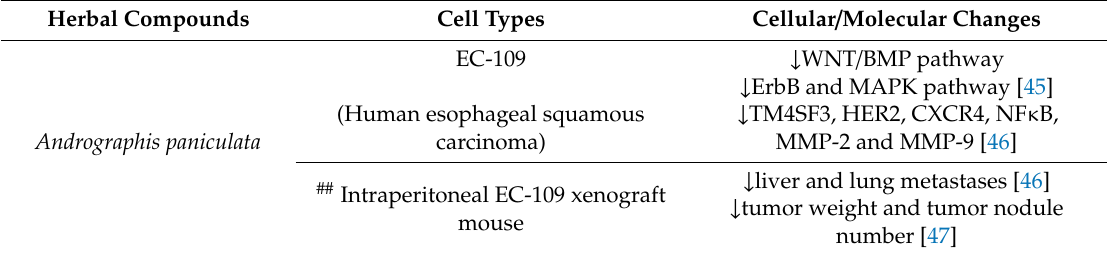
Table 2. Regulatory Impacts of THM compounds for HNSCC Cell Mobility / Metastasis and Angiogenesis. Herbal